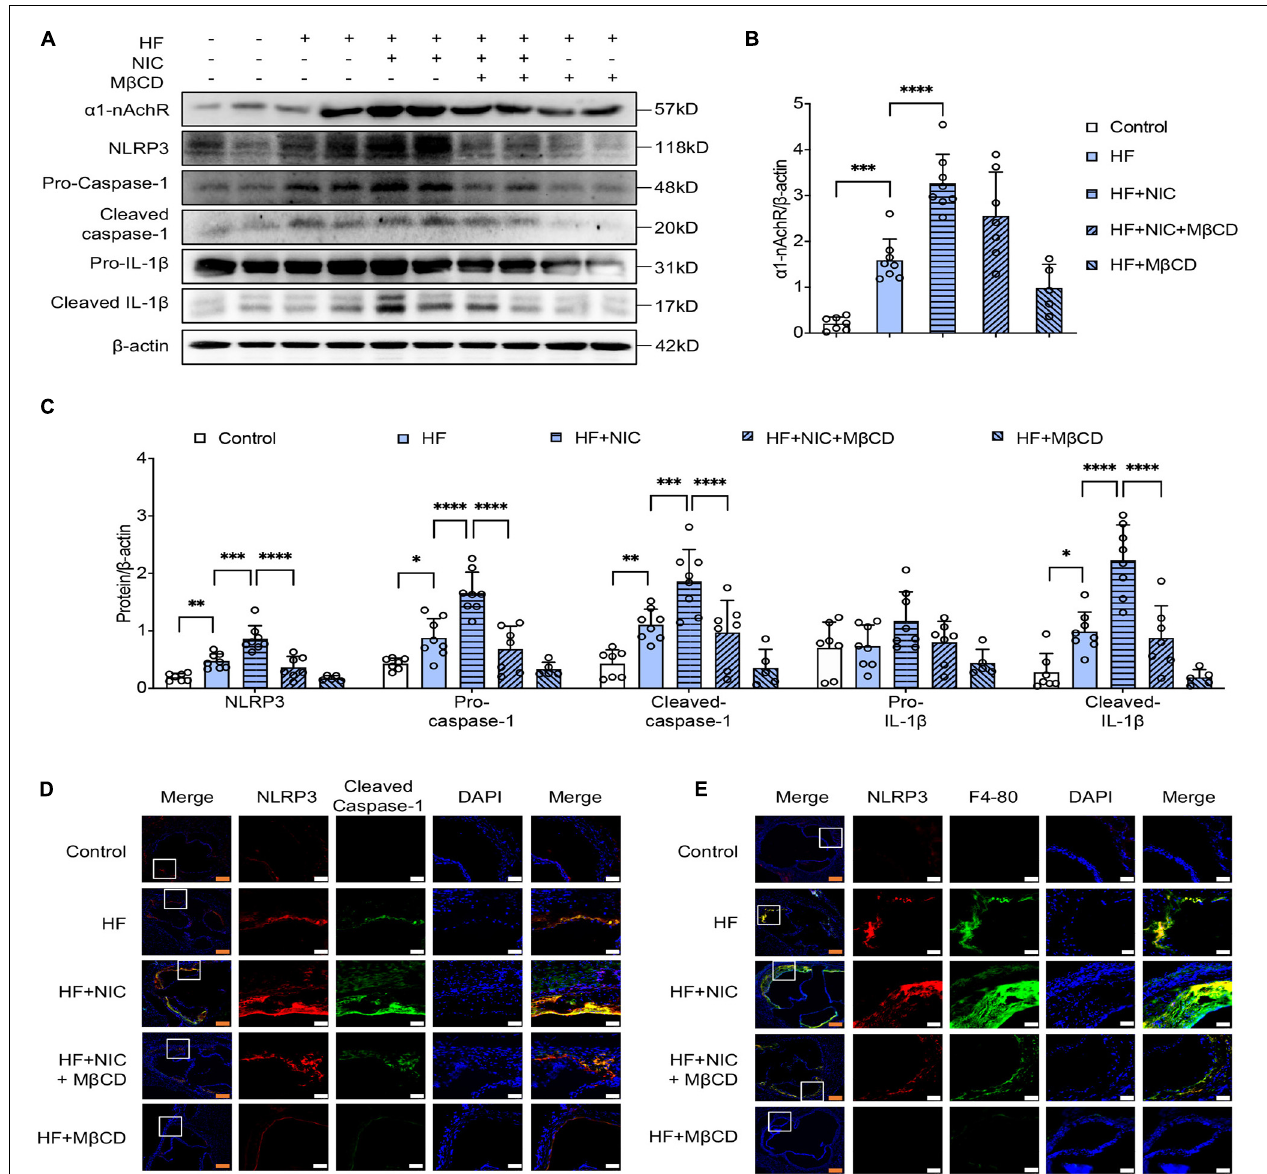
FIGURE 5 | M β CD inhibited nicotine-induced NLRP3 inflammasome activation and macrophage recruitment into atherosclerotic lesion in apoE − / − mice. Mice were randomly divided into control (wild type, normal diet, n = 7), high fat (HF) (apoE − / − , n = 8), nicotine (apoE − / − , n = 8, high-fat diet), nicotine plus M β CD (apoE − / − , n = 7, high-fat diet), and M β CD (apoE − / − , n = 5, high-fat diet) groups. Protein from mice aorta was collected and western blot was performed. (A–C) Representative blots and quantitative analysis of a1-nAchR, NLRP3, pro- and cleaved caspase-1 and IL-1 β , n = 3. (D,E) Representative confocal microscopic images showing colocalization of NLRP3 (red) with caspase-1 (green) (D) , NLRP3 (red) with F4-80 (green) (E) in atherosclerotic lesion. White bars = 25 µ m, orange bars = 100 µ m. All data are represented as mean ± SD. ANOVA test followed by Holm–Šídák post-hoc test was used for statistical analysis. ∗ p < 0.05, ∗∗ p < 0.01, ∗∗∗ p < 0.001, ∗∗∗∗ p < 0.0001. NIC, nicotine; NLRP3, Nod-like receptor protein 3; M β CD, methylcyclodextrin; HF, high-fat diet; F4-80, macrophage